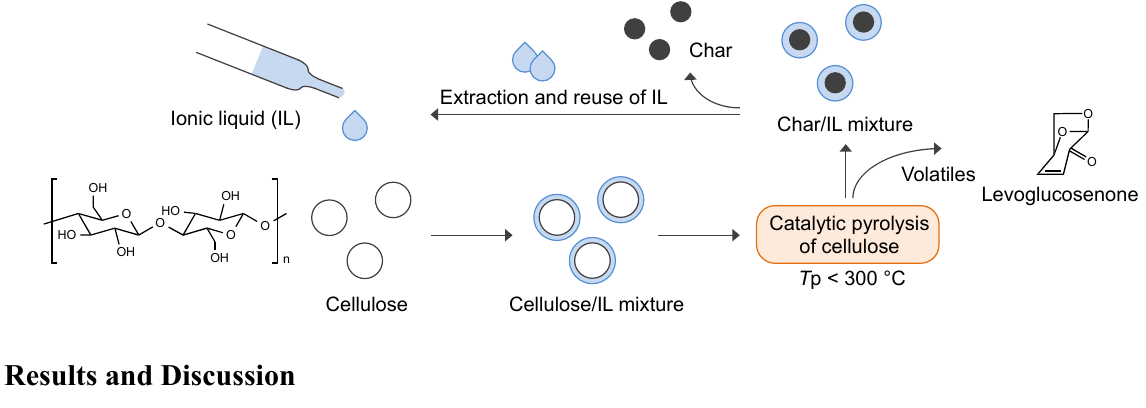
Figure 1. Process flow of cellulose pyrolysis using ionic liquid (IL) as a recyclable